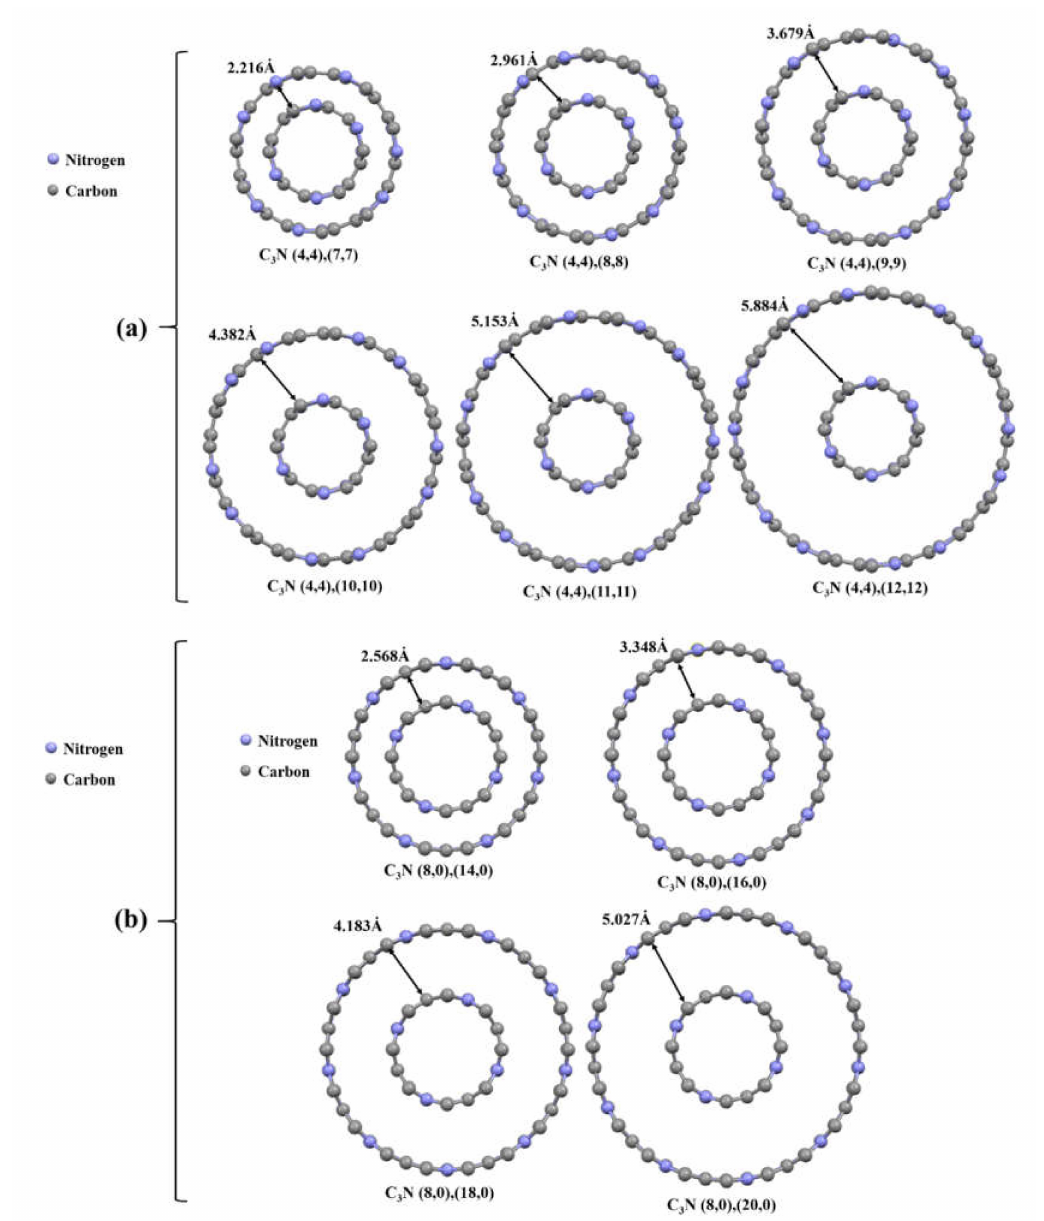
Figure 6. Cross-sectional view of the structure of studied C3NNTs nanotubes: ( a ) armchair DWC3NNTs, and ( b ) zigzag